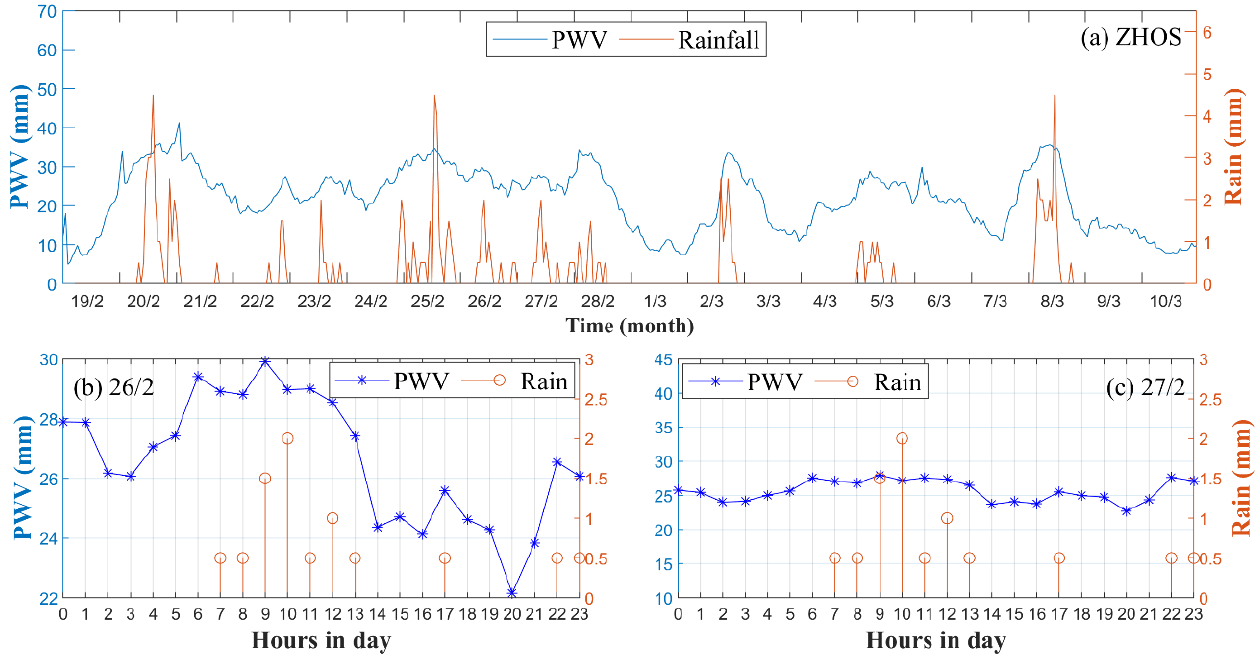
Figure 12. Relationship between hourly PWV and rainfall at ZHOS station over the period from 19 February to 10 March 2015, where ( a ) refers the time series of PWV and rainfall over the period of 19 February to 10 March 2015, ( b , c ) are the hourly PWV and rainfall on 26 February and 7 March, respectively.